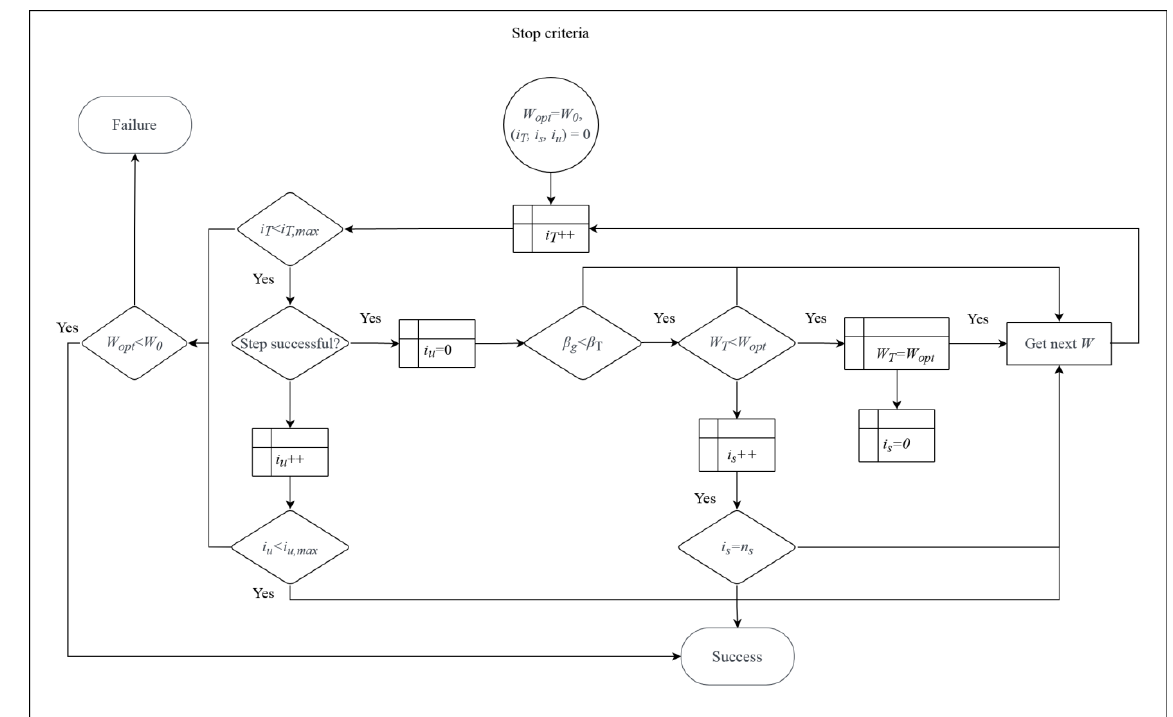
Figure 4. Definition of stop criteria.